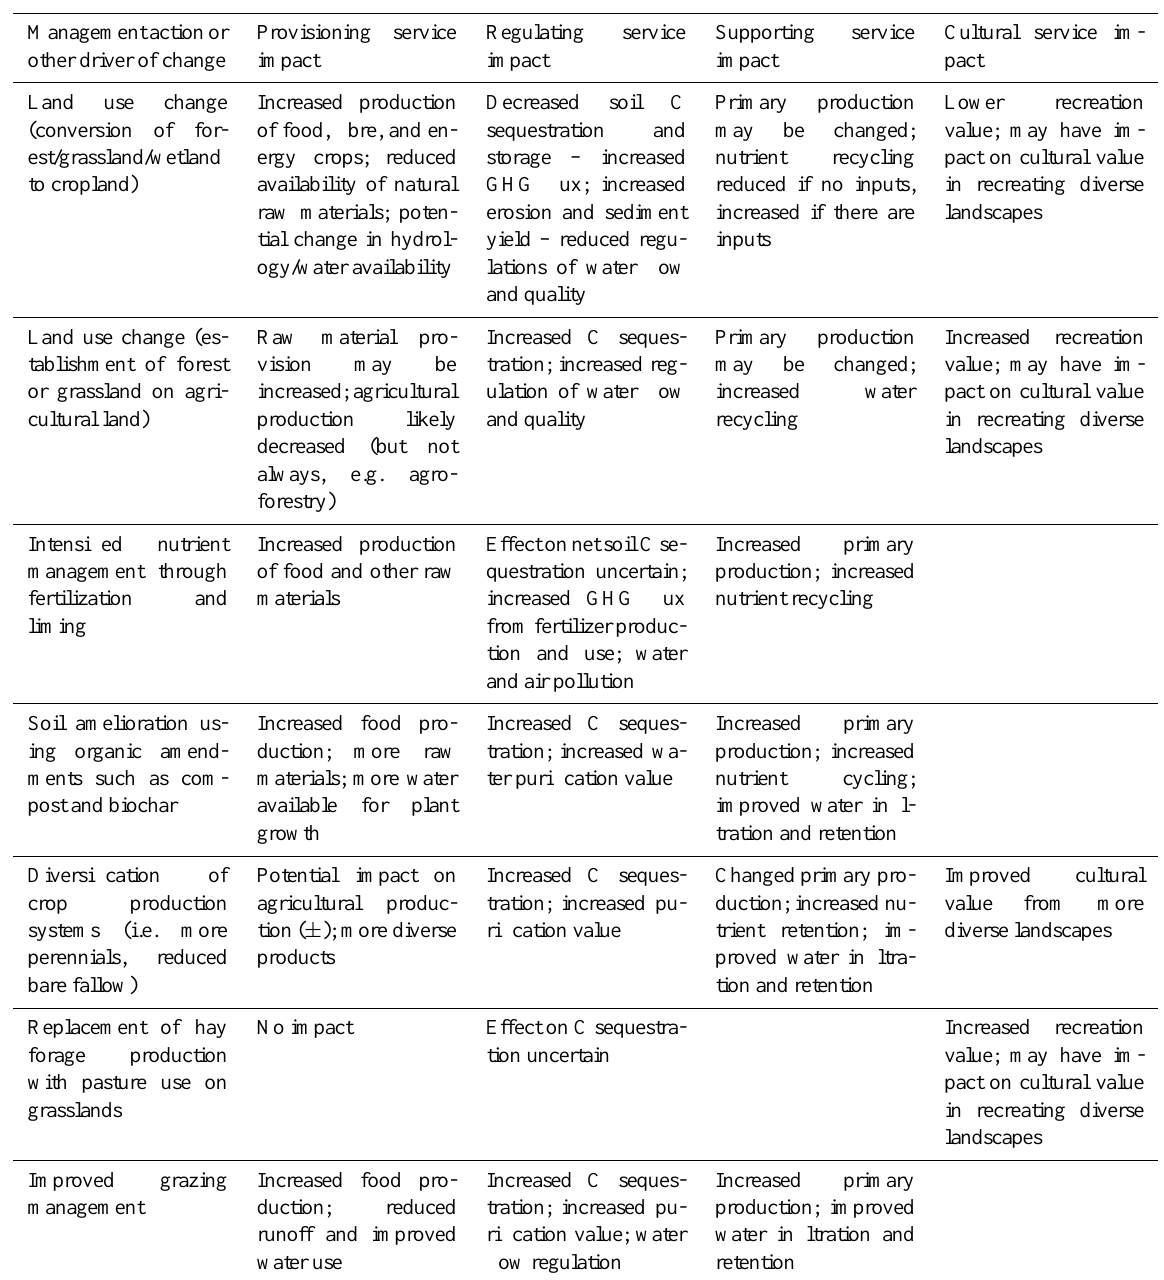
Table 1. Management actions affecting the soil carbon cycle and their impact on ecosystem